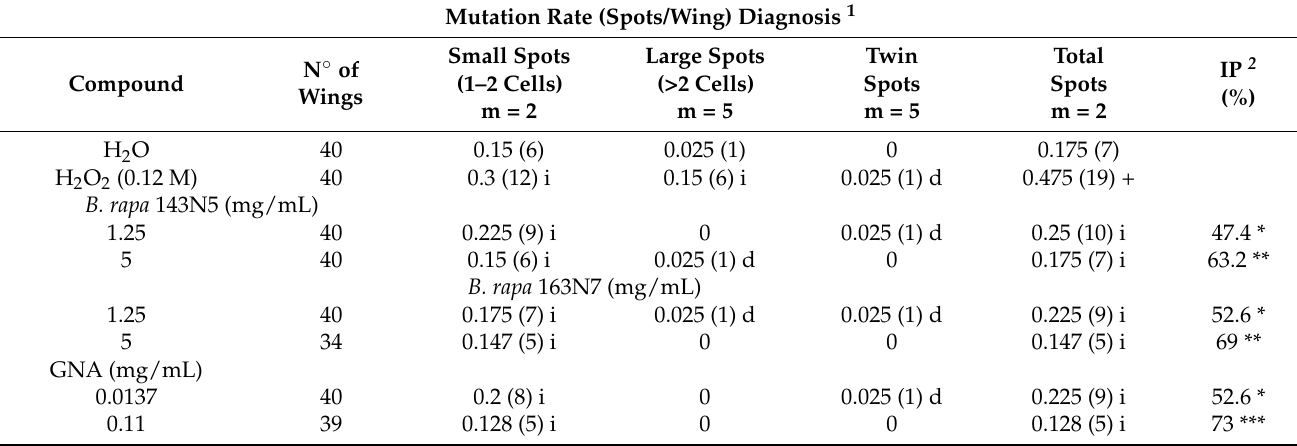
Table 5. Antigenotoxicity of B. rapa cultivars and gluconapin (GNA) in the Drosophila wing spot test. Mutation Rate (Spots/Wing) Diagnosis